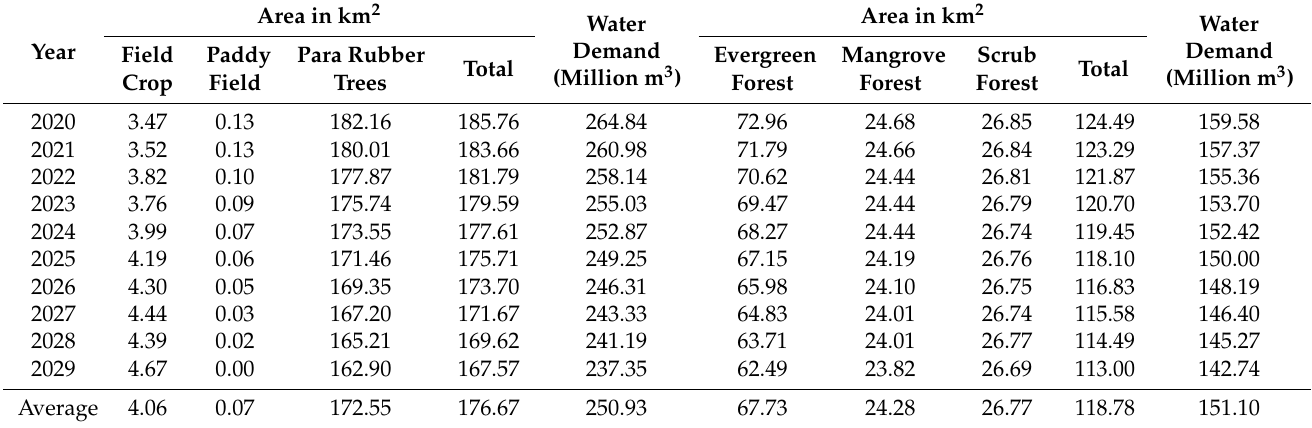
Table 23. Area of each agriculture and forest type and water demand between 2020 and